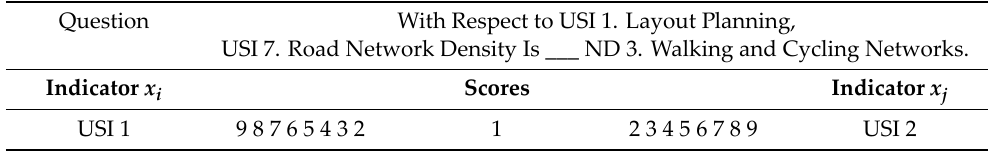
Table 6. Example of the scoring questions.